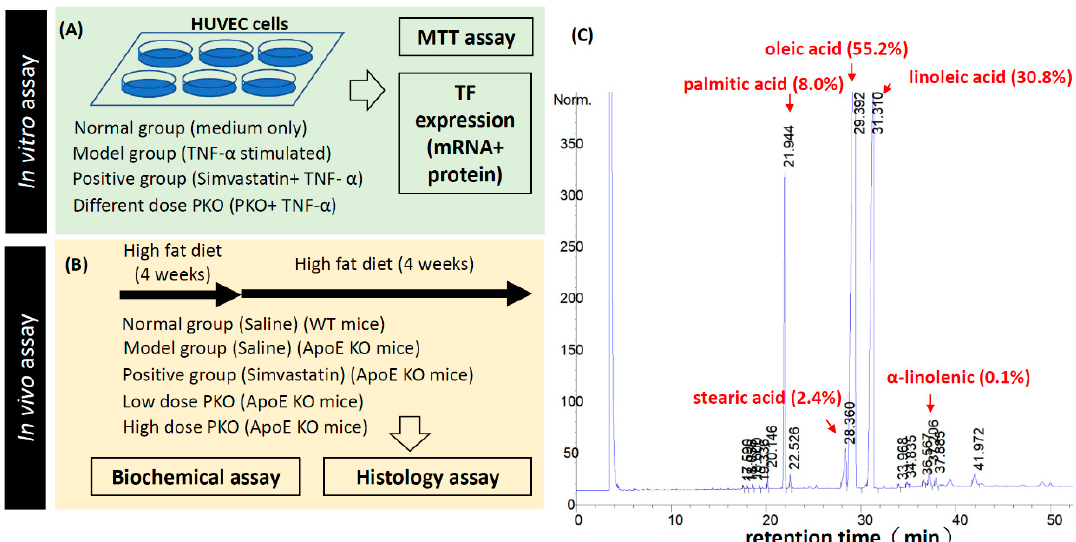
Figure 1. Experimental design, workflow and chemicals used in this study. ( A ) Peach kernel oil on human umbilical vein endothelial cells (HUVEC) endothelial cells viability; ( B ) Peach kernel oil on reducing atherosclerosis in ApoE knockout (KO) mice; ( C ) GC-MS analysis of the major components of peach kernel oil. PKO stands for peach kernel oil.